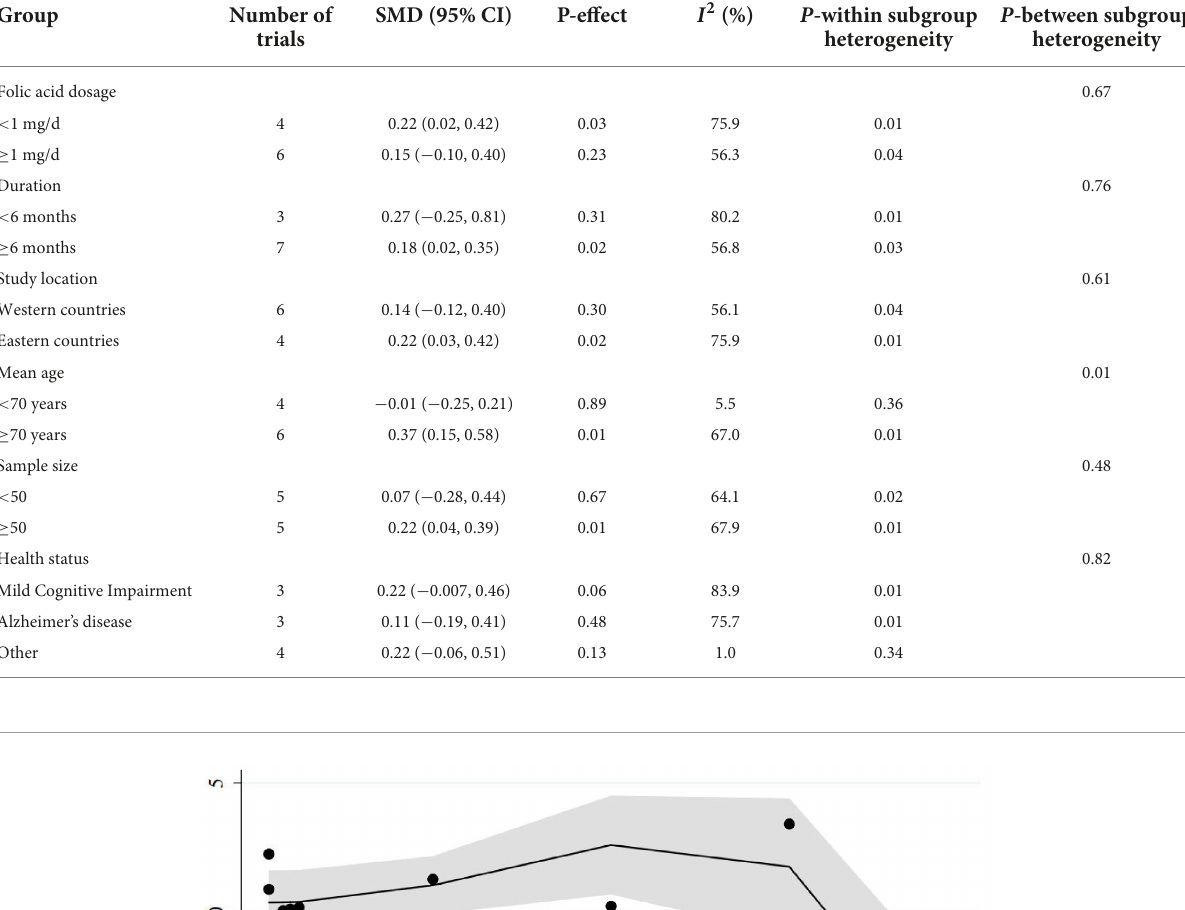
TABLE 3 Pooled estimates of folic acid supplementation among different subgroups.